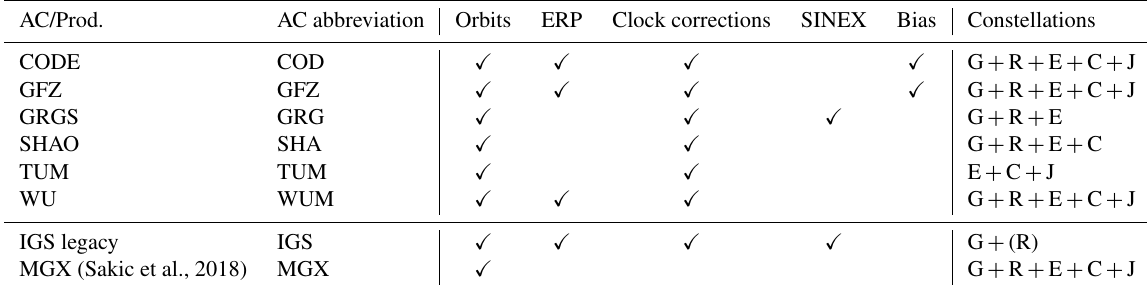
Table 1. Analysis Centers and their product submissions, as reference also IGS legacy and MGX (Sakic et al., 2018) are added. AC/Prod.